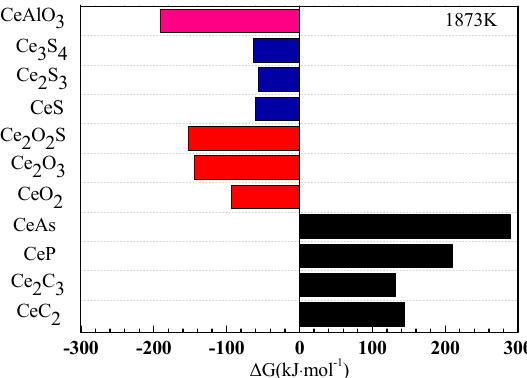
Metals 2019 , 9 , x FOR PEER REVIEW Figure 8. The Formation of the Gibbs free energy of the cerium inclusions at 1873 K.